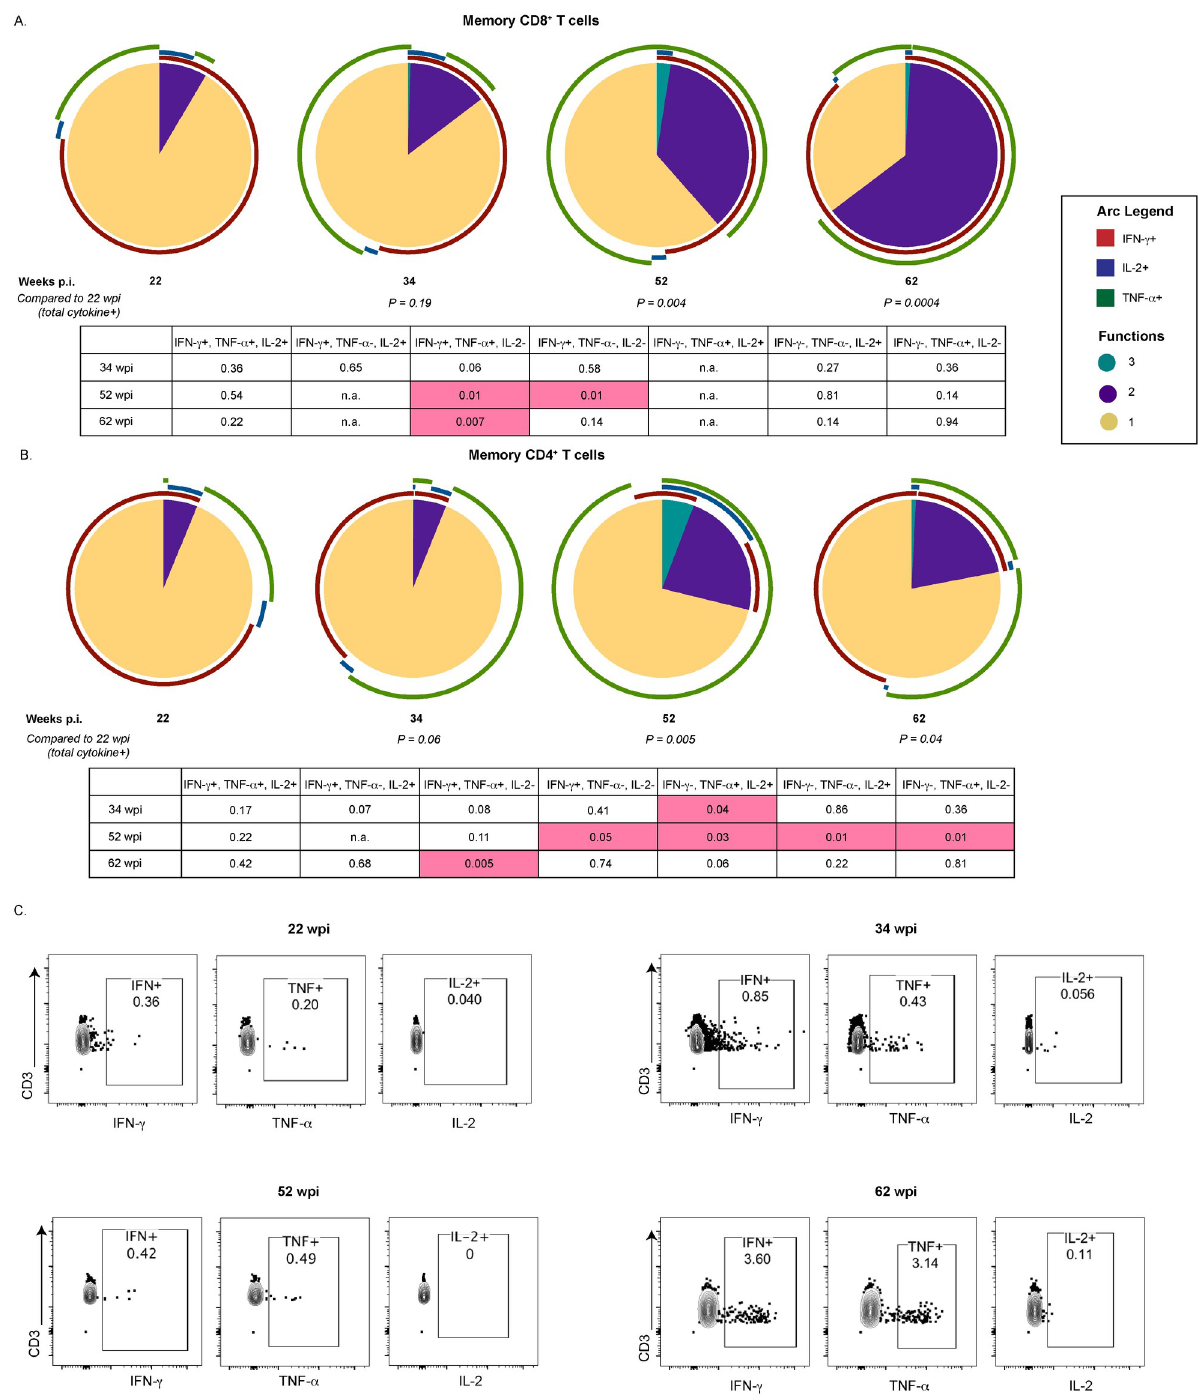
Fig 3. Immunological response measured by ICS to therapeutic vaccination in SIV-infected, ART-treated infant RMs. Pie charts depicting the ability of (A) memory CD8 + and (B) memory CD4 + T cells isolated from TV+TLR7 RMs to produce IFN- γ , IL-2 and/or TNF- α in response to stimulation with SIV mac239 Gag peptide pool at 22 (n = 5), 34 (n = 6), 52 (n = 4), and 62 (n = 7) weeks post infection (wpi). Total cytokine positive cells were compared to week 22 through permutation test. Cytokine positive subsets were compared to week 22 using a Wilcoxon Rank Sum Test, table representing P values is shown. (C) Representative flow plot of IFN- γ , TNF- α , and IL-2 expression in CD95 + CD8 + T cells.